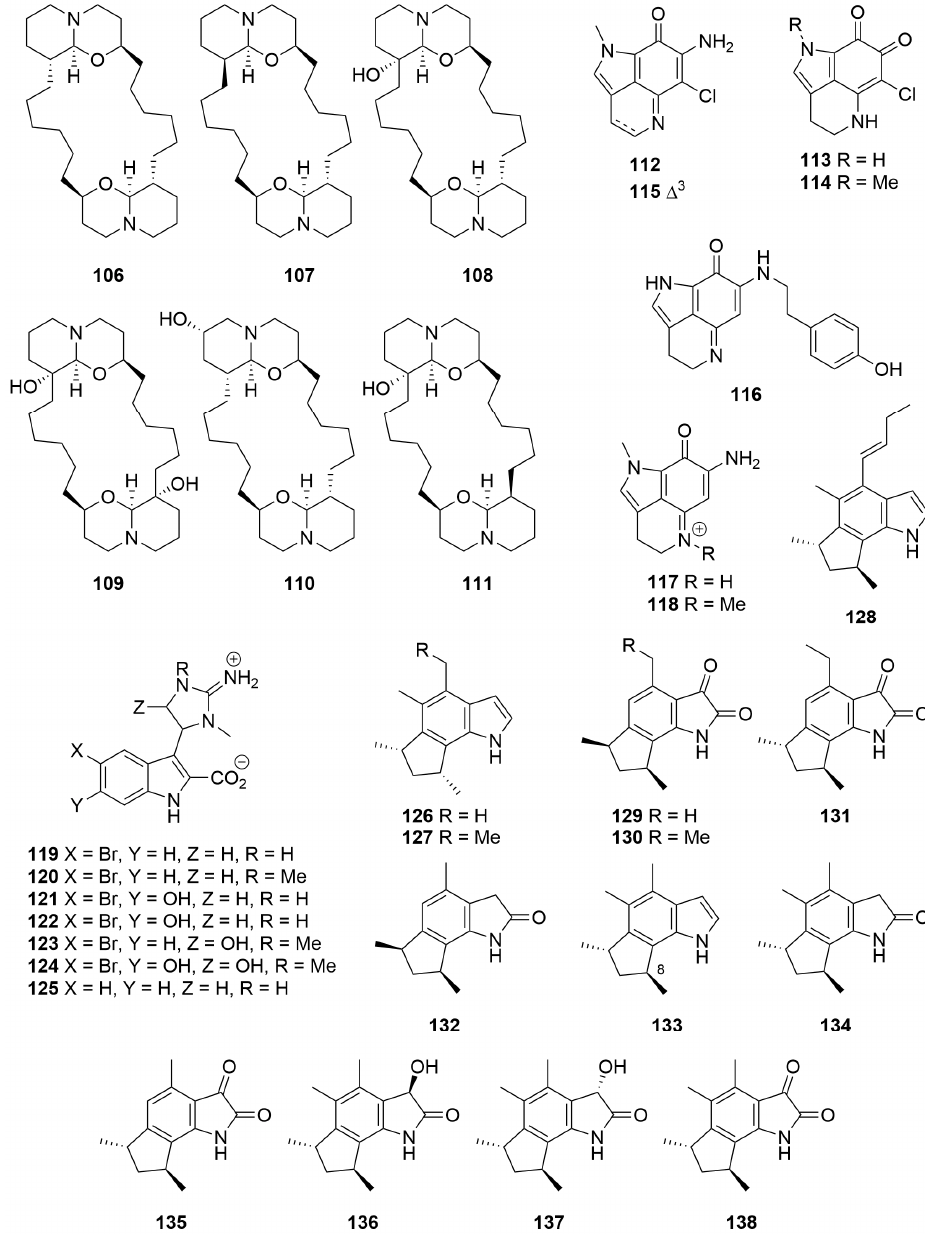
Figure 7. Compounds 106 to 138